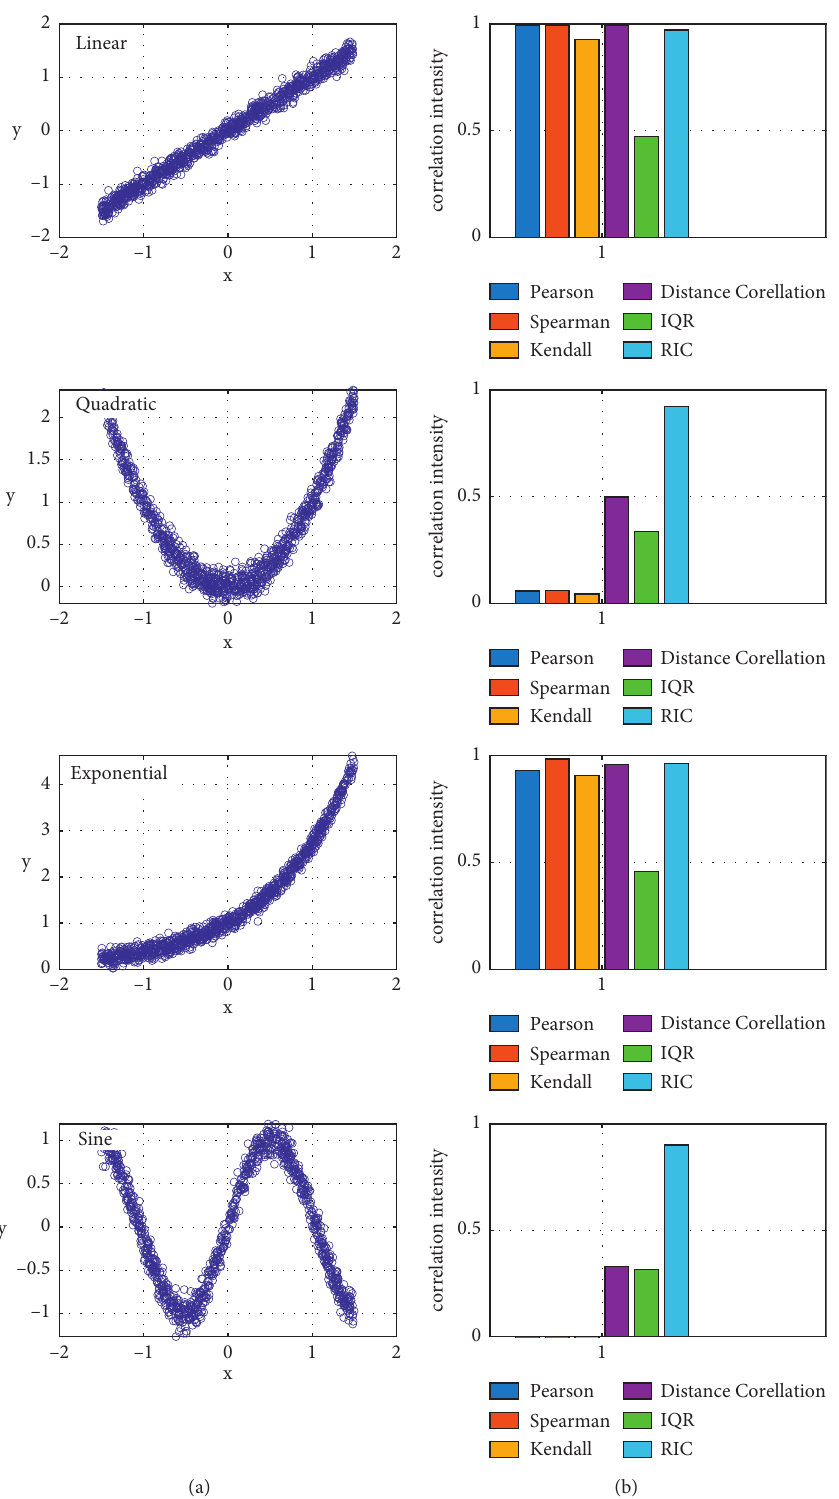
Figure 1: The main classes of functions tested. (a) Examples of synthetic data. (b) The numerical values of the